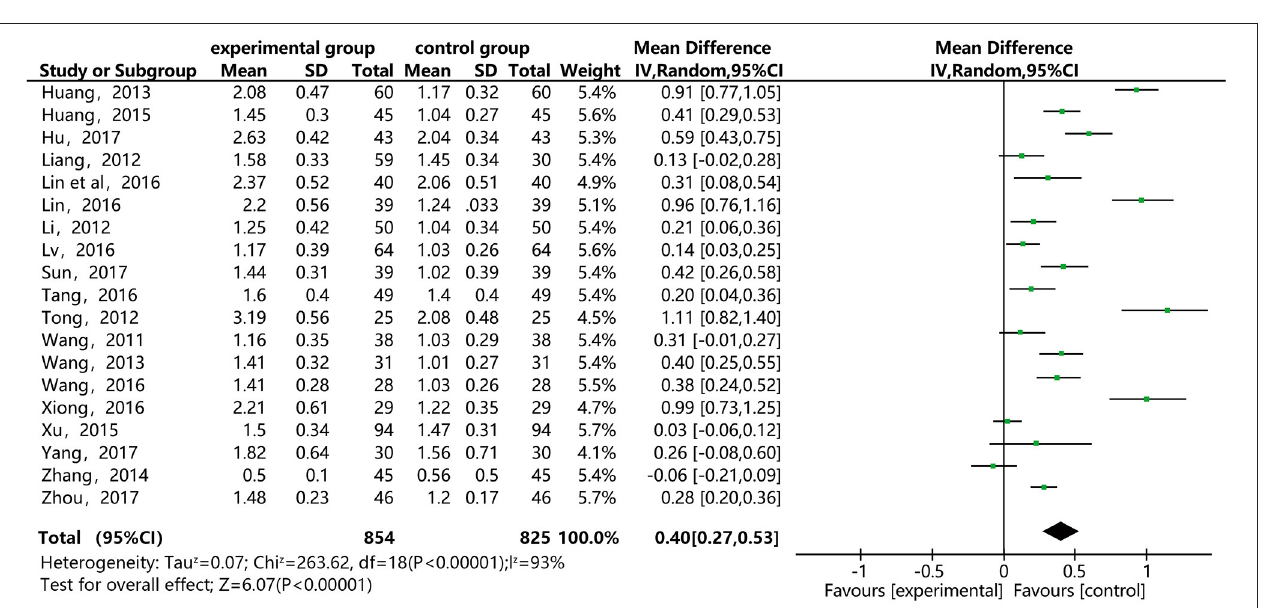
FIGURE 5 | Meta-analysis forest map for the effect of DSP combined with aspirin on TG in patients with CHD.